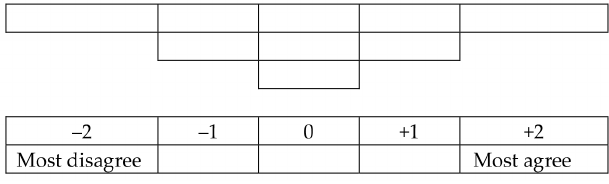
Figure 1. Shape of the used Q-grid (Loučanová et al.,